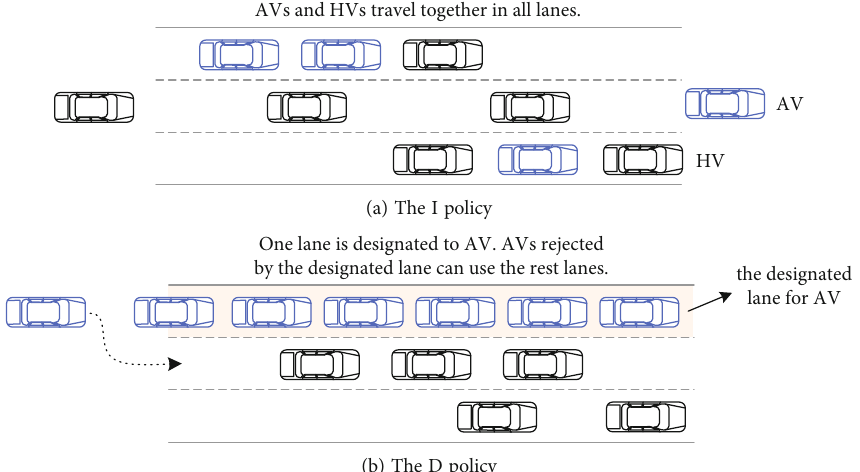
Figure 1: The I policy and the D policy.